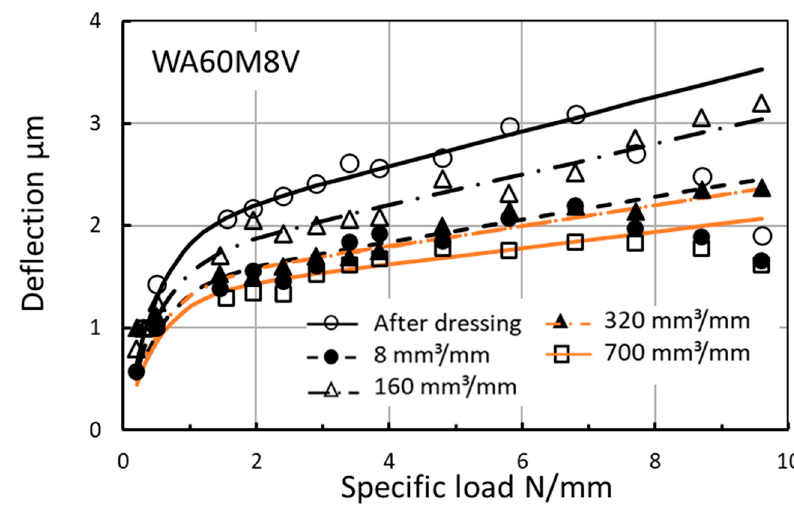
Figure 19. The e ff ect of accumulative specific material removal on contact deflection. Figure 19. The effect of accumulative specific material removal on contact deflection.